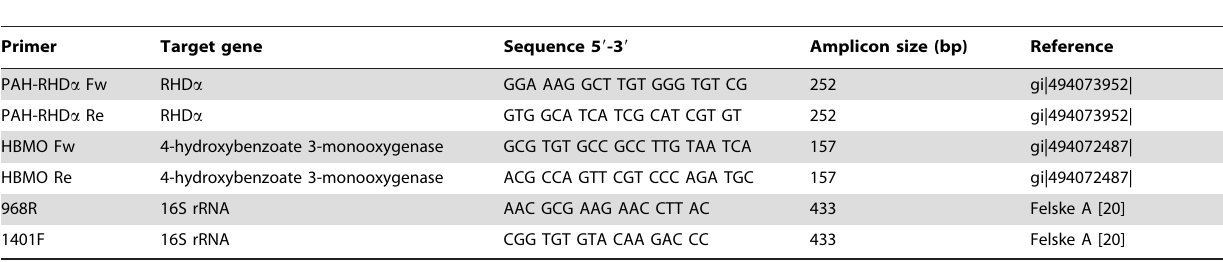
Table 1. Characteristics of PCR primer sets used in this study.